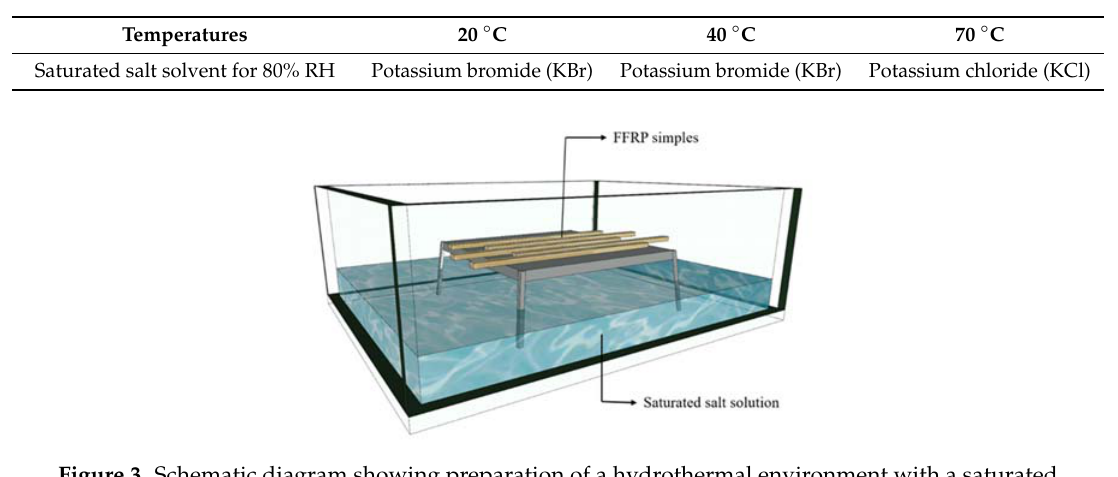
Figure 3. Schematic diagram showing preparation of a hydrothermal environment with a saturated salt solution.